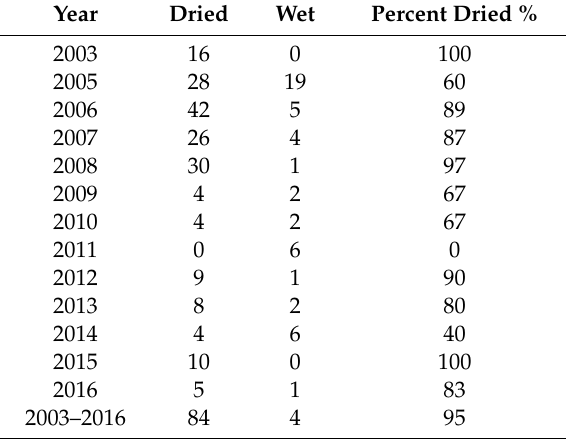
Table 1. Number of seasonal Prairie Pothole Region wetlands that dried (Dried) and remained at least partially inundated (Wet), by year, and that dried at least once during the study period (2003–2016). Percent dried is the percentage of wetlands that dried by year, and during the study period. Year Dried Wet Percent Dried